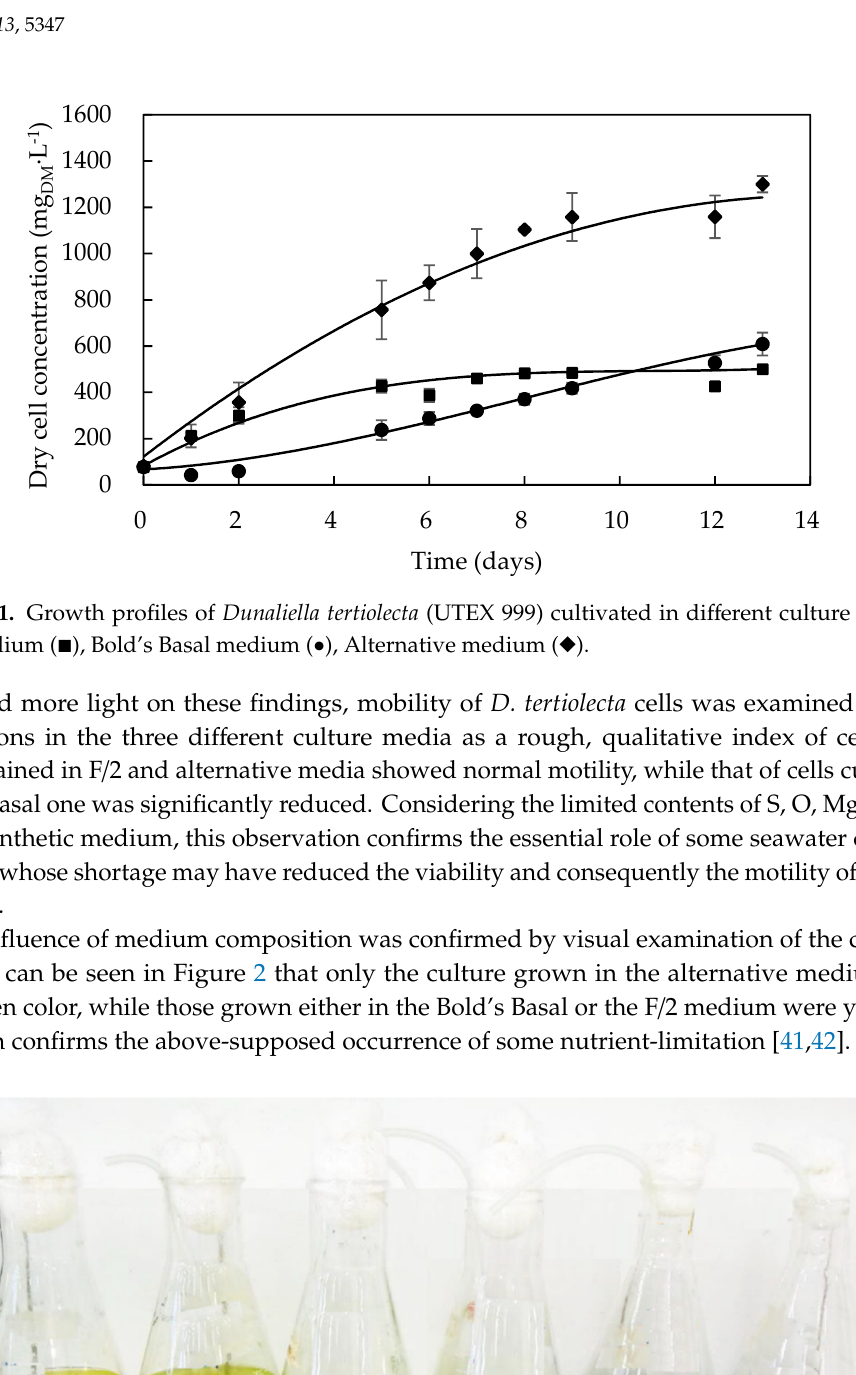
Figure 2. Color of D. tertiolecta (UTEX 999) cultivations in different culture media: F/2 medium ( A ), Bold’s Basal medium ( B ), Alternative medium ( C ).